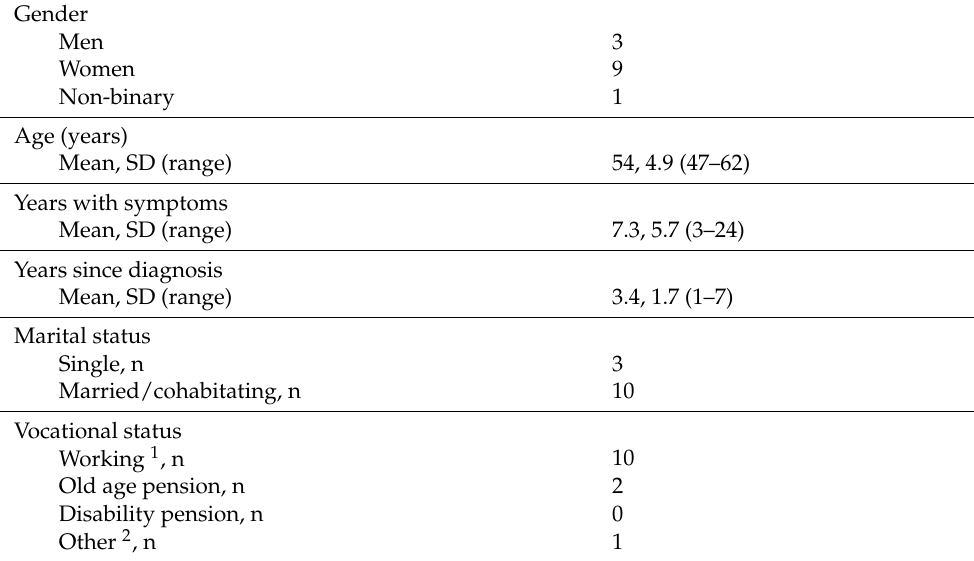
Table 1. Characteristics of the 13 participants with Parkinson’s